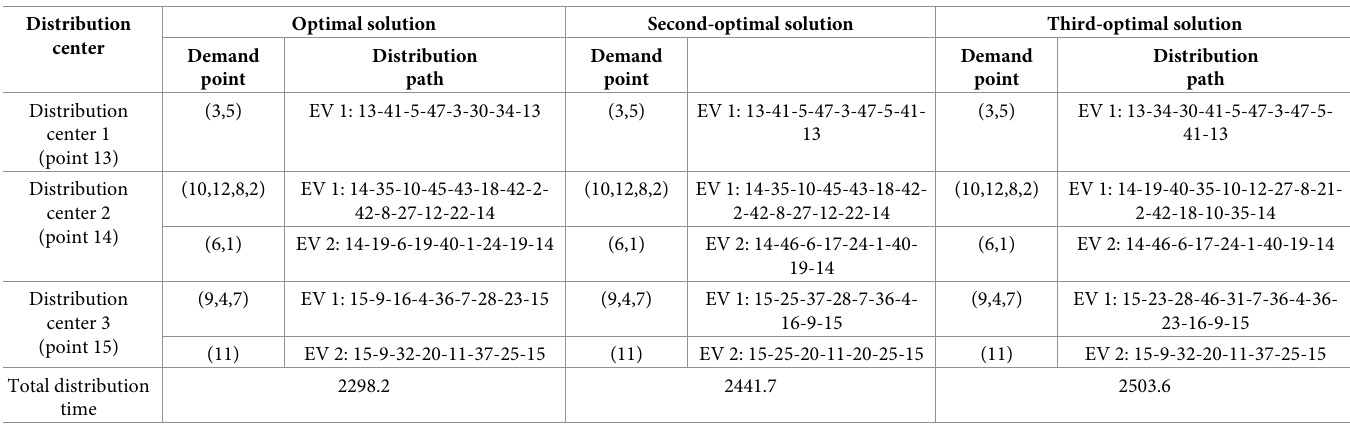
Table 3. Solution set when T = 20